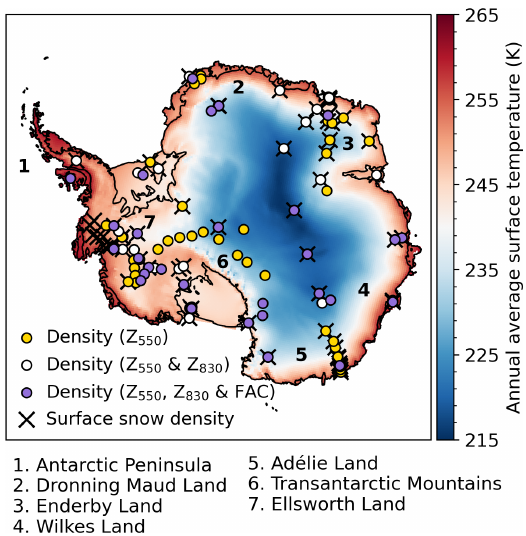
Figure 1. Map of Antarctica showing annual average sur- face temperature from the Regional Atmospheric Climate Model (RACMO2.3p2; 1979–2020) and the locations of the in situ den- sity observations. The yellow circles indicate observational loca- tions of the depths of the critical density level of ρ = 550kgm − 3 ( z 550 ), the white circles indicate observational locations of the depths of the critical density levels of both ρ = 550kgm − 3 ( z 550 ) and ρ = 830kgm − 3 ( z 830 ), the purple circles indicate observa- tional locations of the depths of the critical density levels of both ρ = 550kgm − 3 ( z 550 ) and ρ = 830kgm − 3 ( z 830 ) and of the firn air content (FAC), and the black crosses indicate observational lo- cations of the surface snow densities (top 0.5m of the firn column). The numbers indicate regions mentioned throughout the